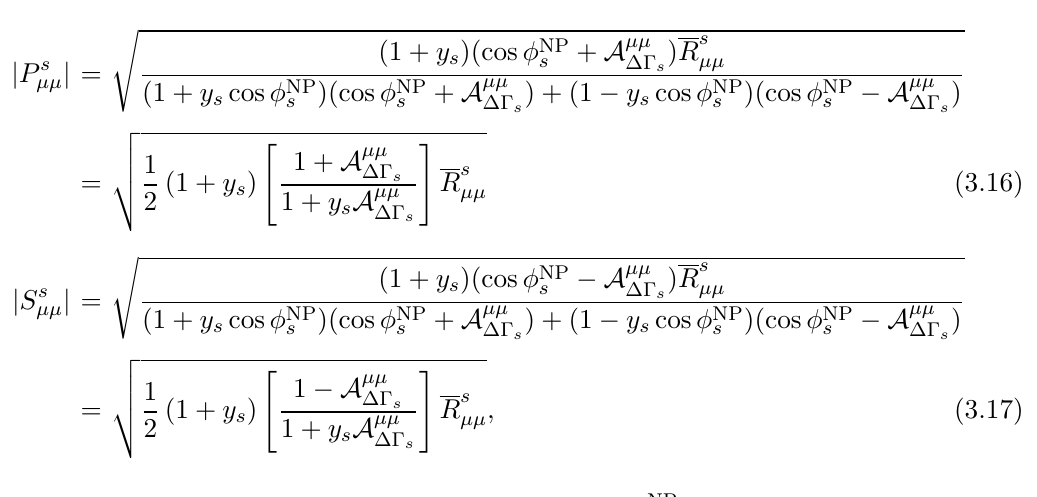
Figure 3 . Constraints in the P s NP phases ’ (cid:22)(cid:22) information for R as illustrated by the dotted and dashed lines, will pin down values for P s